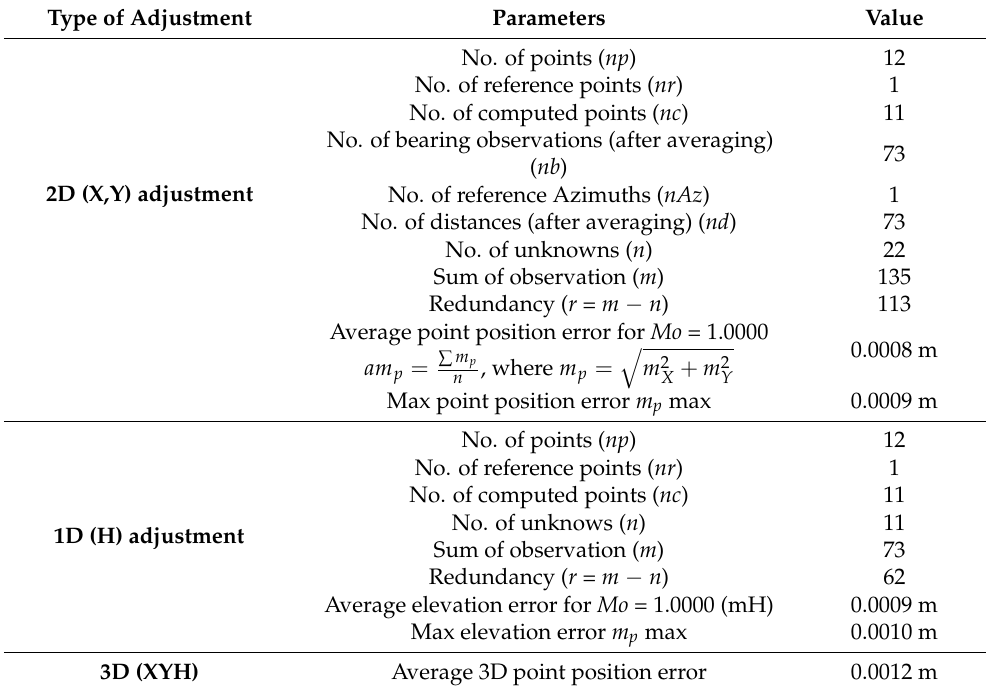
Table 1. Control network adjustment parameters.